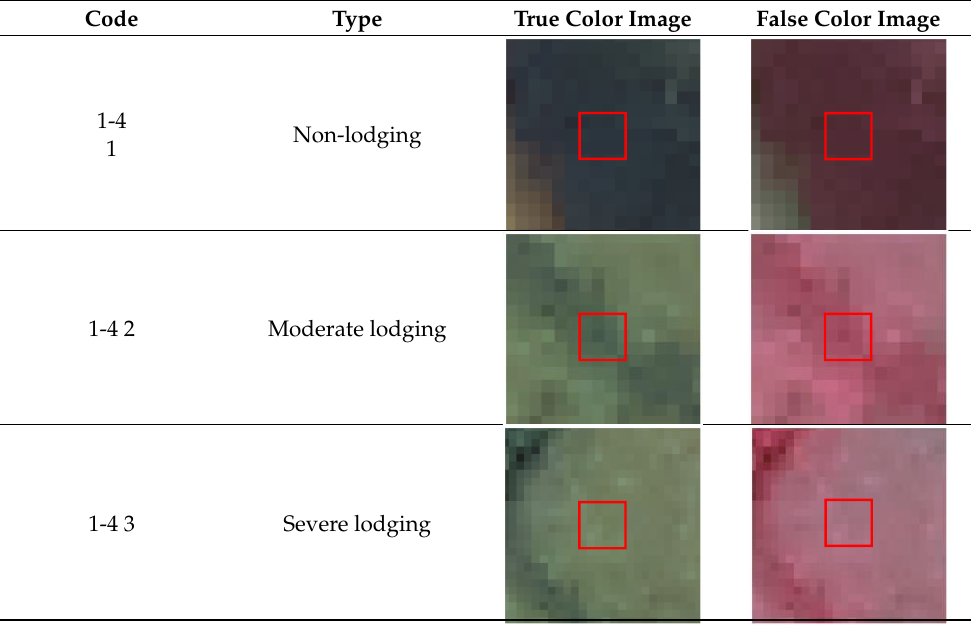
Table 4. Spectral features of non-lodging, moderate lodging, and severe lodging from GF-1 PMS images. images. images. images.